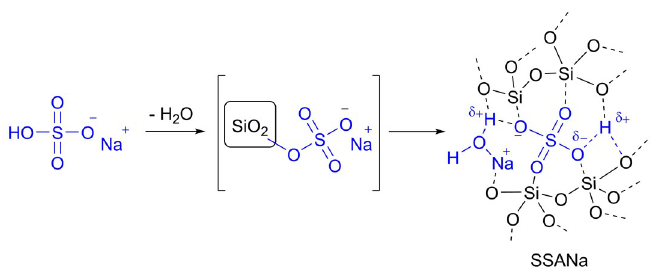
Figure 5. Proposed model describing the adsorption of sodium bisulfate on silica.